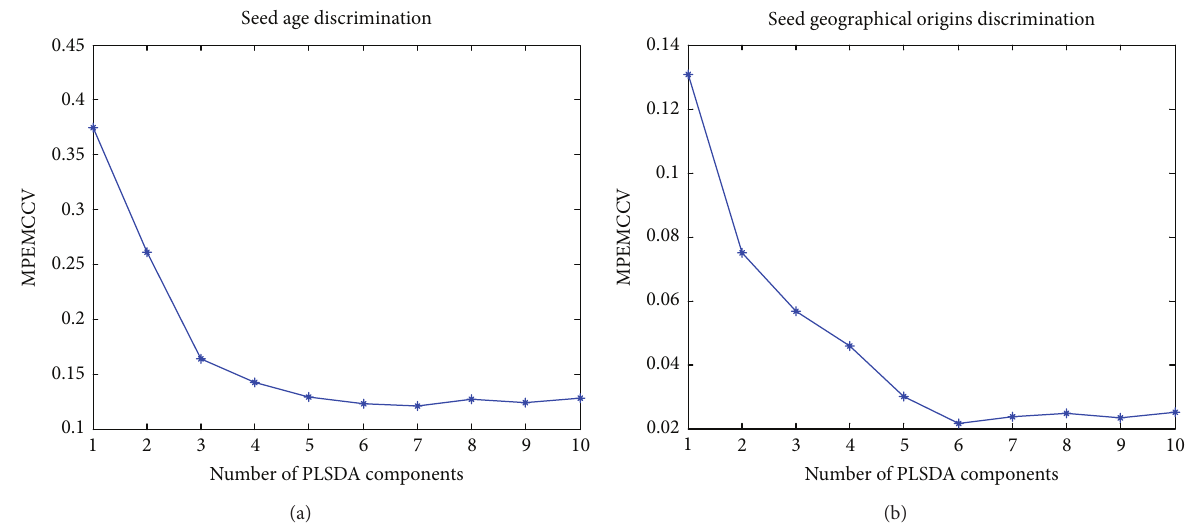
Figure 5: The selection of PLSDA components by MCCV for discrimination of seed age and geographical origins with second derivative spectra (4000–9000 cm −1